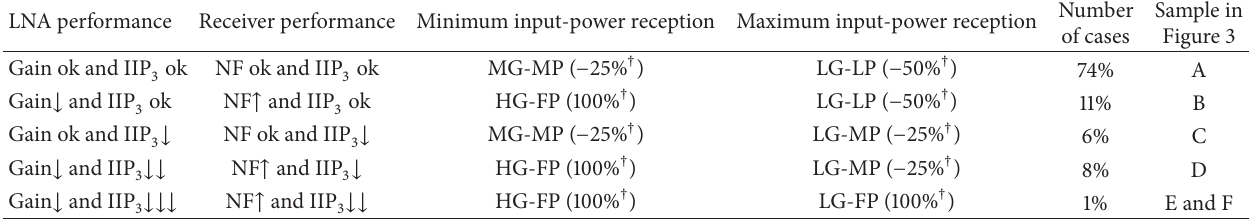
Table 3: Modes utilization at extreme communication-channel conditions, depending on the effects of process variations. LNA performance